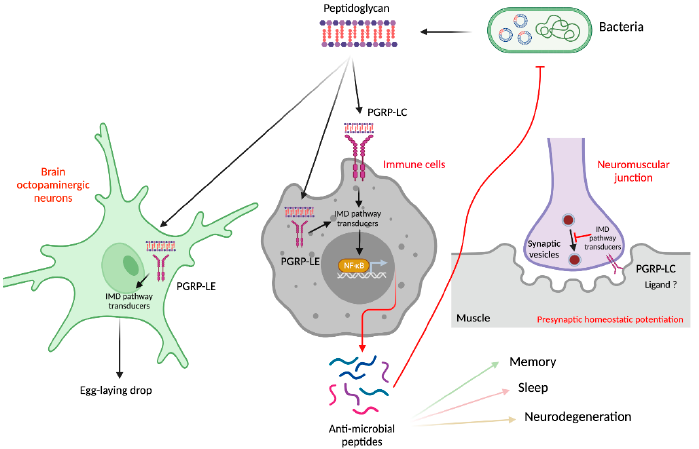
Figure 1. Dual role of the PGN/PGRP/NF- κ B pathway in immune and neuronal cells. (See text for details).